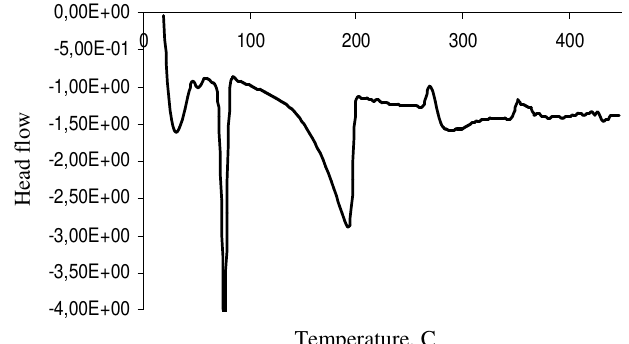
Figure 3b . DSC of Ibuprofen